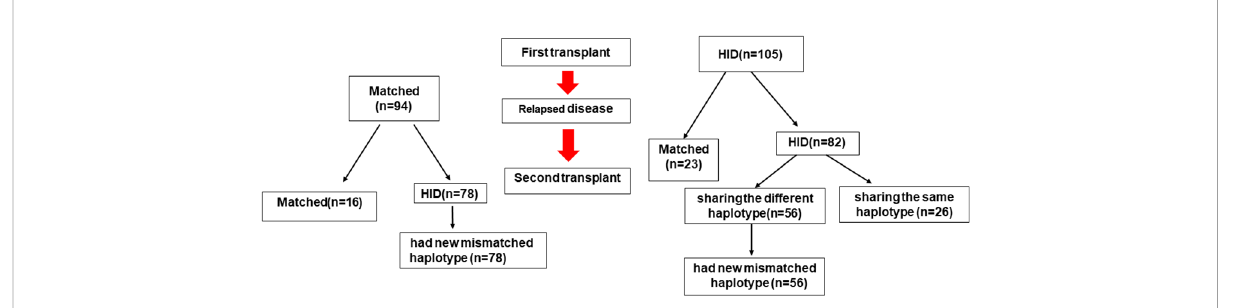
FIGURE 1 HLA-matching pathway. MSD, Matched sibling donor; MUD, matched unrelated donor; HID, haploidentical donor; UCB, unrelated cord blood donor; Auto,